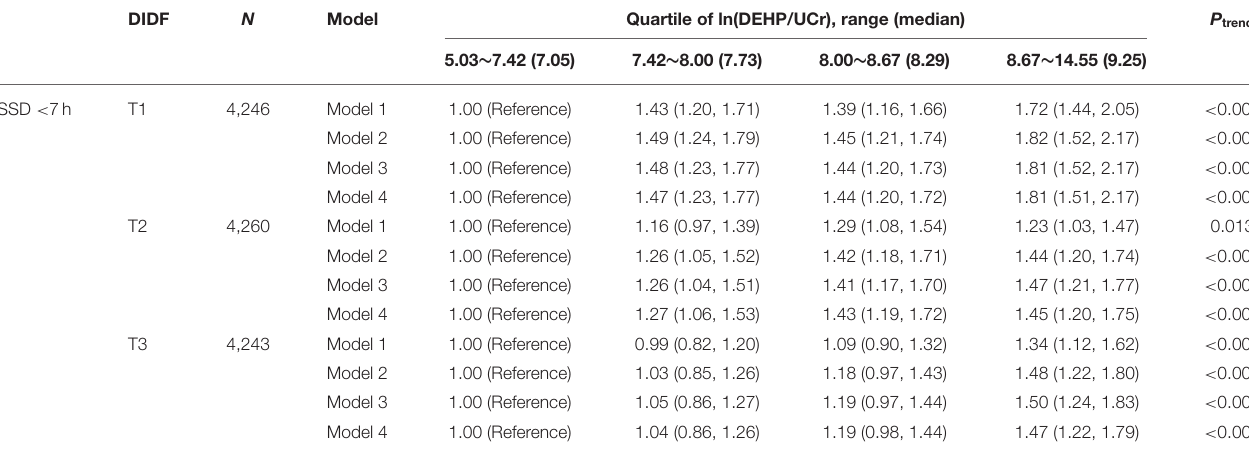
TABLE 5 | Association between DEHP exposure and short sleep duration < 7h in different levels of DDIF.